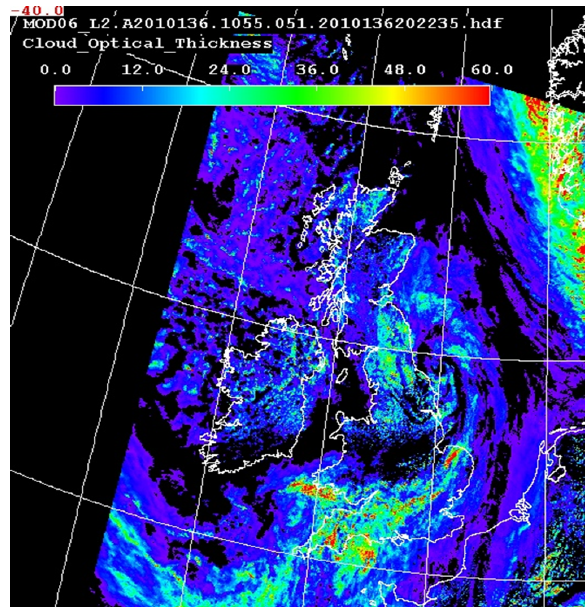
Fig. 7. MODIS cloud optical thickness over the British Isles for 16 May 2010. North of Ireland the COT was around 10 with very small variations.